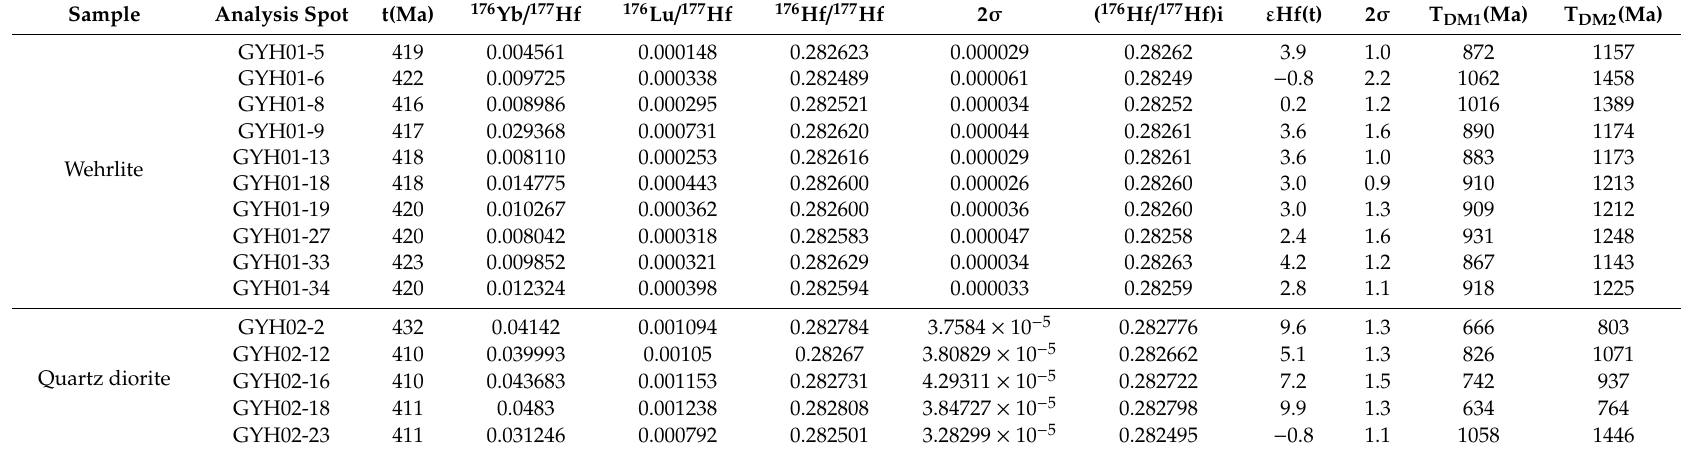
Table 3. Zircon Hf isotopic compositions of wehrlite and quartz